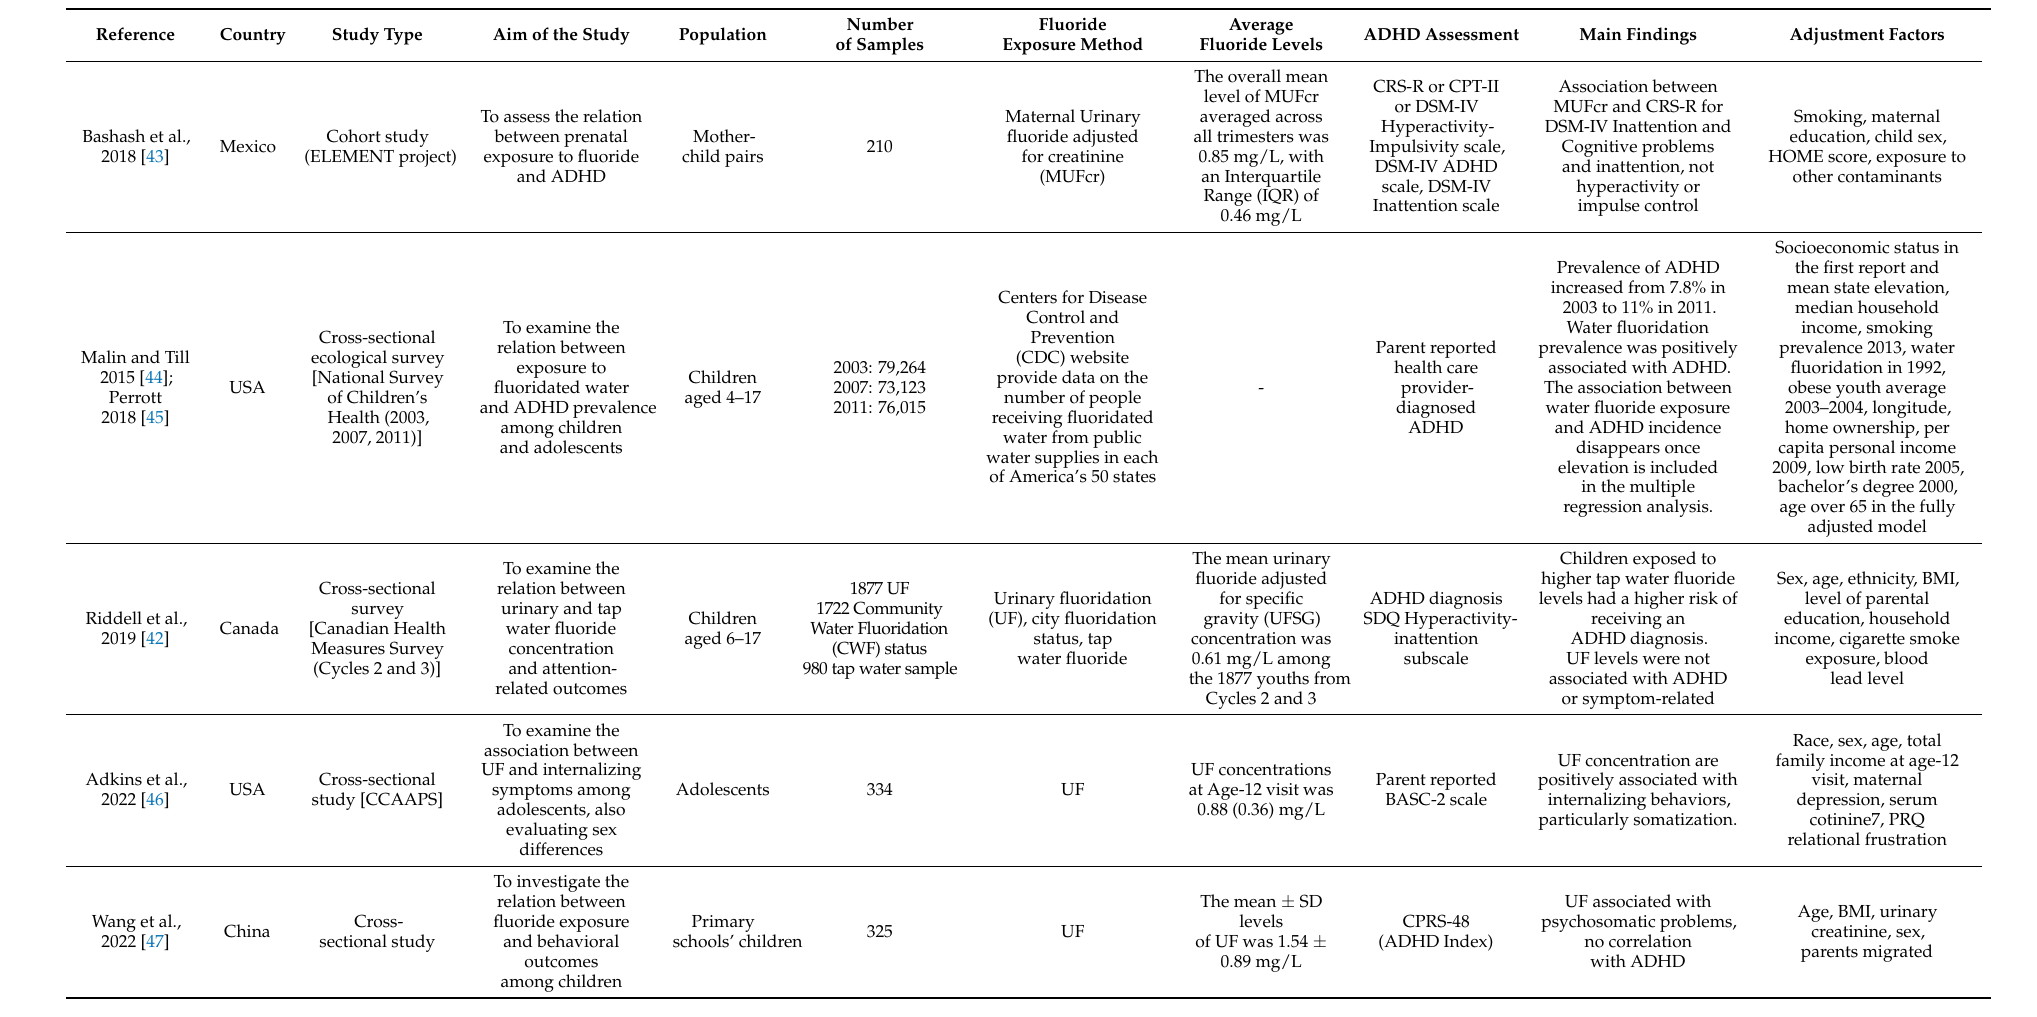
Table 2. Characteristics of the studies included in the